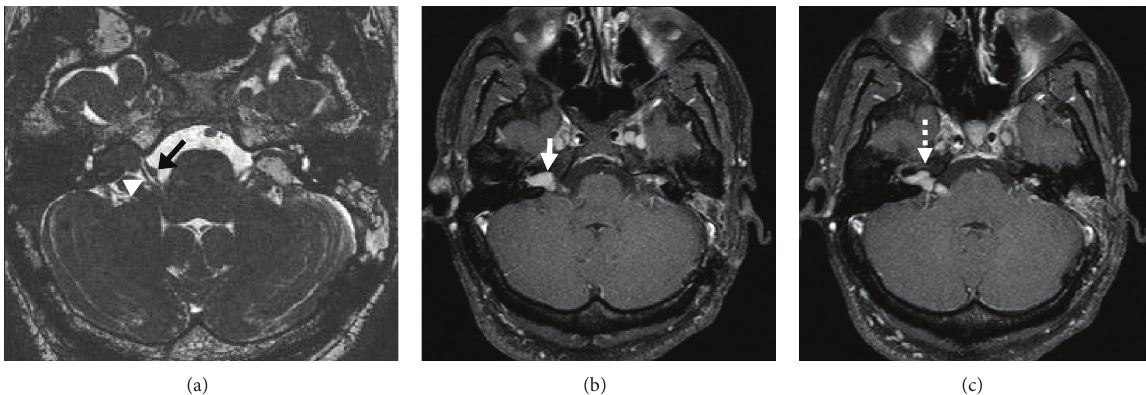
Figure 11: Right CN VII schwannoma in the cerebellopontine angle (CPA) in a patient with neurofibromatosis type II. Axial CISS sequence (a) demonstrates a small lesion along CNVII (black arrow), which courses anterior to CNVIII (white arrowhead) in the right CPA cistern. Axial T1 postcontrast fat-saturated images (b)-(c) demonstrate the enhancement of the right facial schwannoma (solid white arrow, (b)). Also note the vestibular schwannoma in the right IAC (dashed white arrow, (c)) and residual enhancement with postsurgical changes in the region of the left IAC.